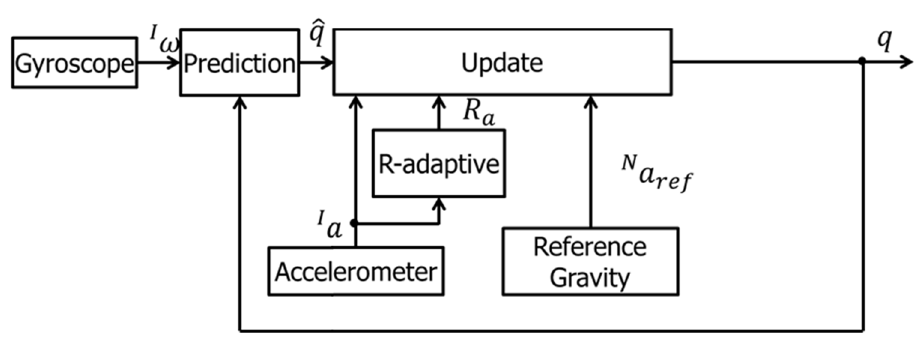
Figure 10. EKF process flowchart.